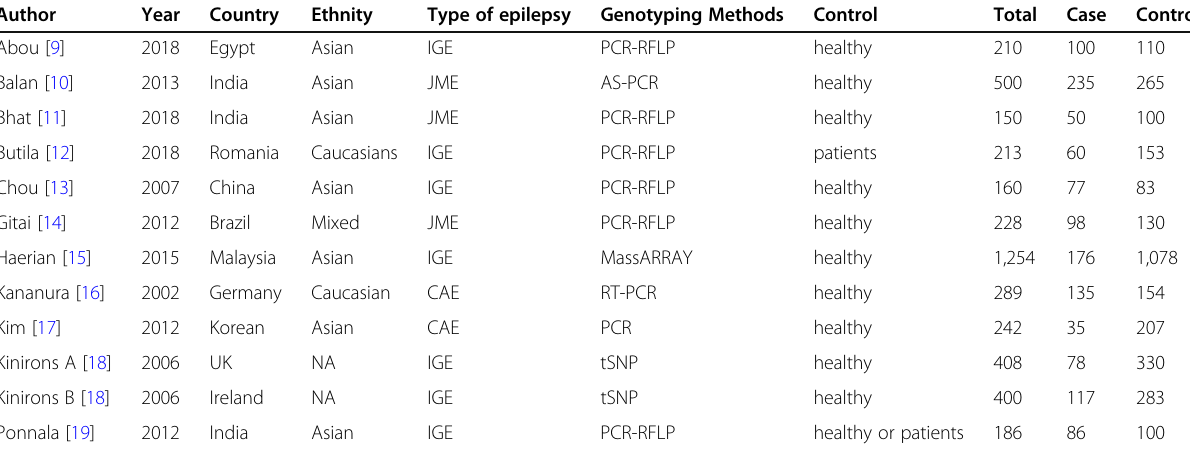
Table 1 Baseline characteristic of eligible case-control